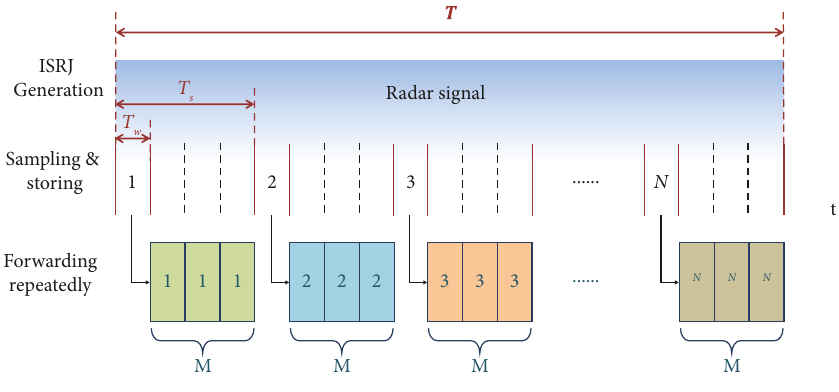
Figure 1: The formation process of